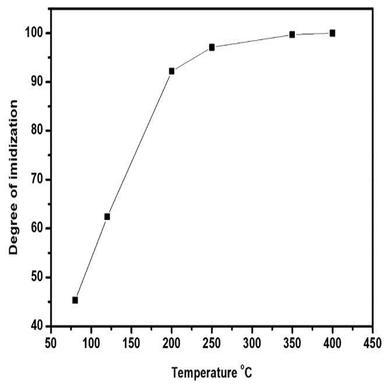
Degree of imidization of PI films prepared at various imidization temperatures.